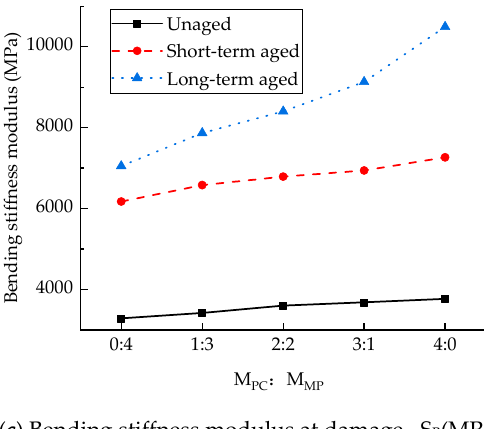
Figure 5. Low-temperature bending test results of asphalt mixture for di ff erent aging conditions.